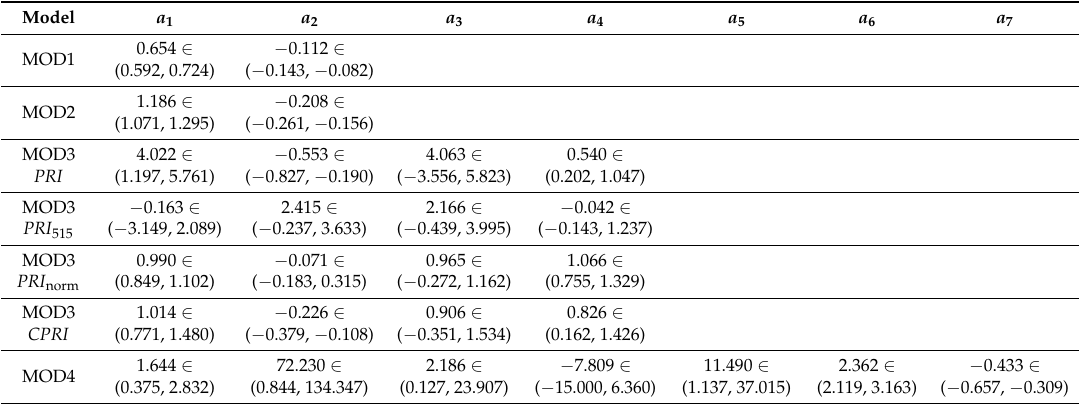
Table 4. Parameters with 95% confidence intervals for the different models retrieved using the “Flight”